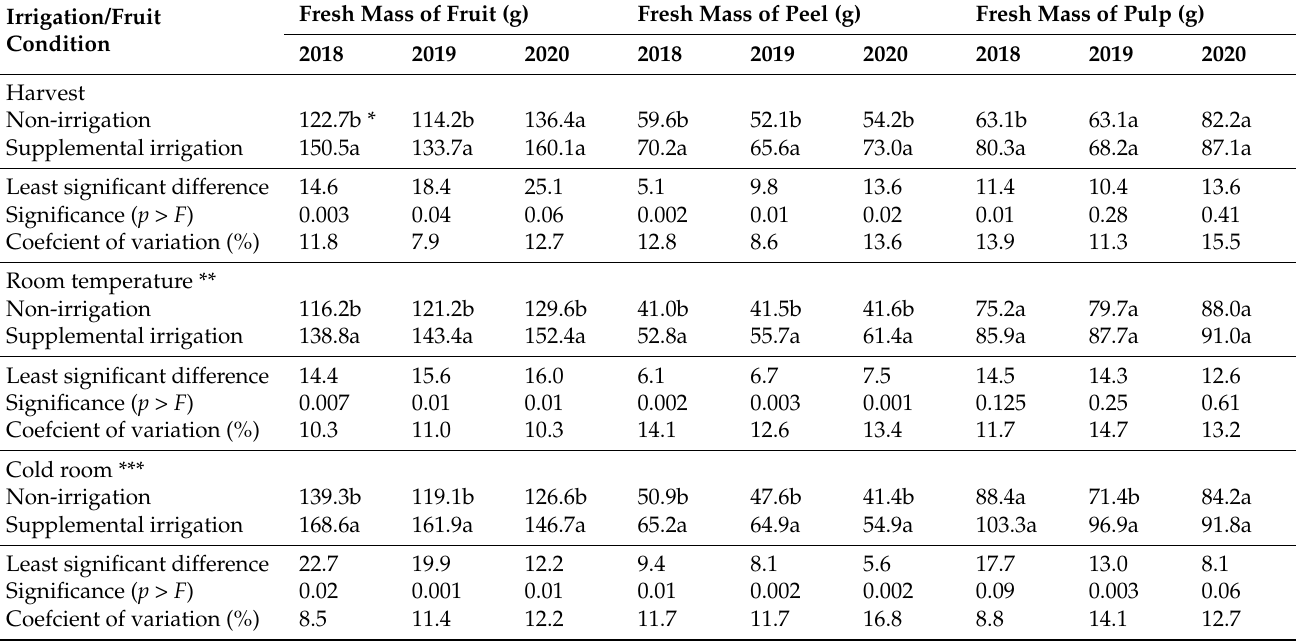
Table 6. Number and percentage (in brackets) of fruit with decay from ‘Roja Lisa’ cactus pear plants under different irrigation treatments and storage conditions in three consecutive growing seasons.